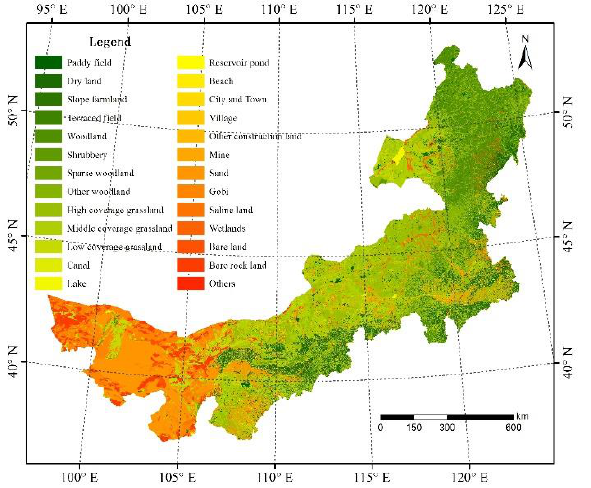
Figure 2.Land Use Map of Inner Mongolia Region in 1978